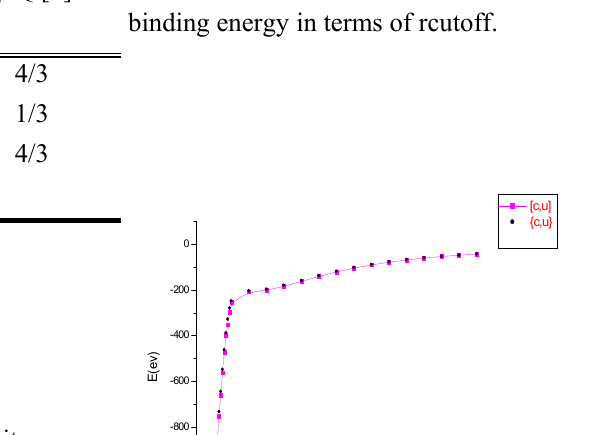
Table 1. Masses and form factor parameters of the diquarks Quark Content